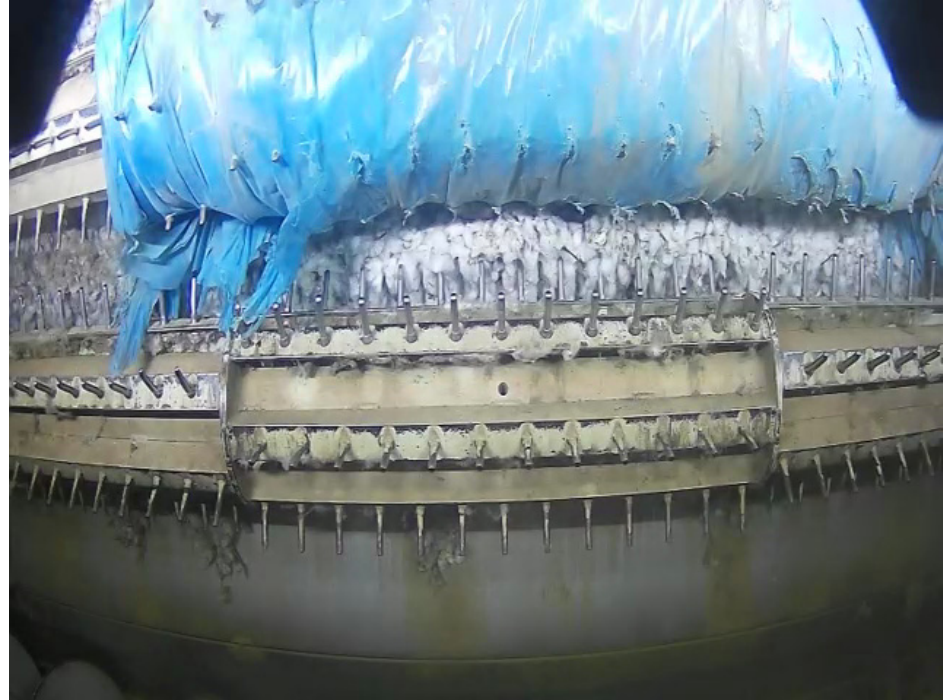
Figure 2. Module feeder image capture by inspection system with plastic on dispersing cylinders.